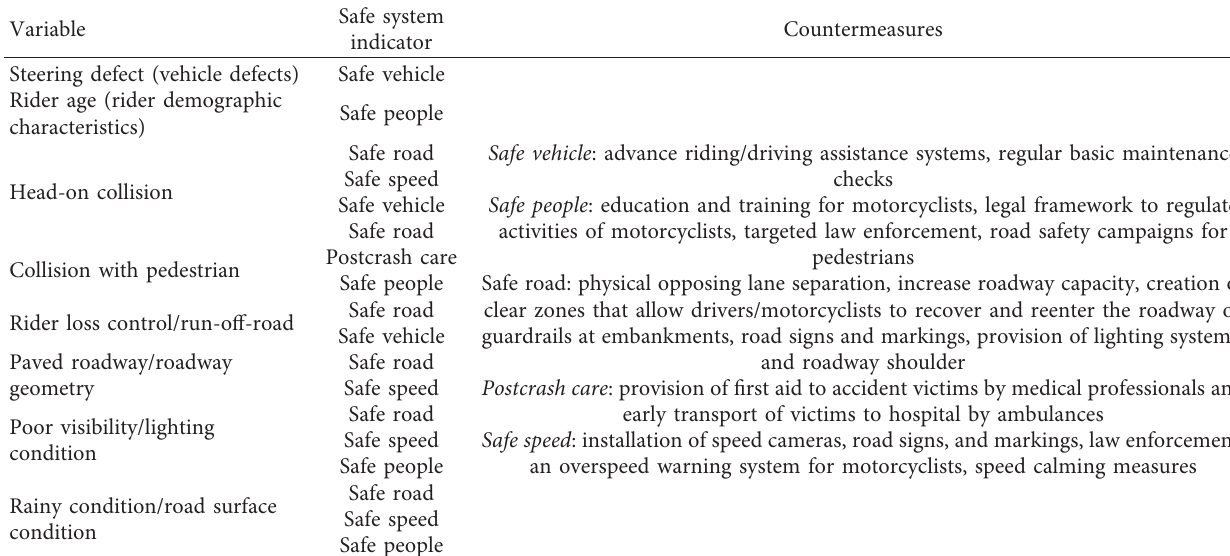
Table 5: Safe system approach for the rural and urban environment with respect to fatal